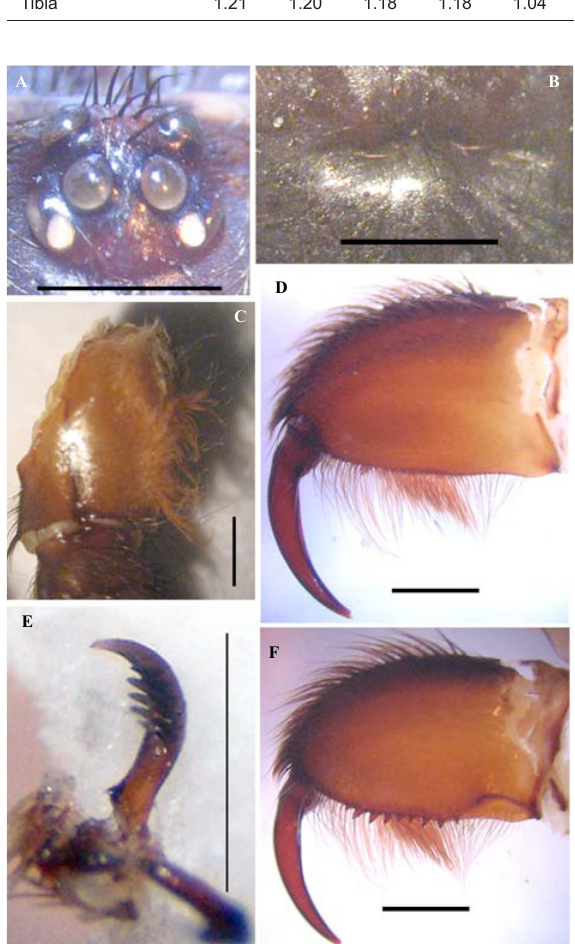
Figure 5. S. arthrapophysis male. A. Arrangement of eyes, ocular tubercle. B. Fovea. C. Image 5. S. arthrapophysis male (ZSI/FBRC/A-25). Maxilla, prolateral view. D. Cheliceral, retrolateral face. E. Claw, showing small denticle ( ca. A - Arrangement of eyes, ocular tubercle; B - Fovea; 6) on one side. F. Cheliceral, prolateral face. (Scale for A−D & F = 1mm; E = 0.5mm). C - Maxilla, prolateral view; D - Cheliceral, retrolateral face; E - Claw, showing small denticle (ca . 6) on one